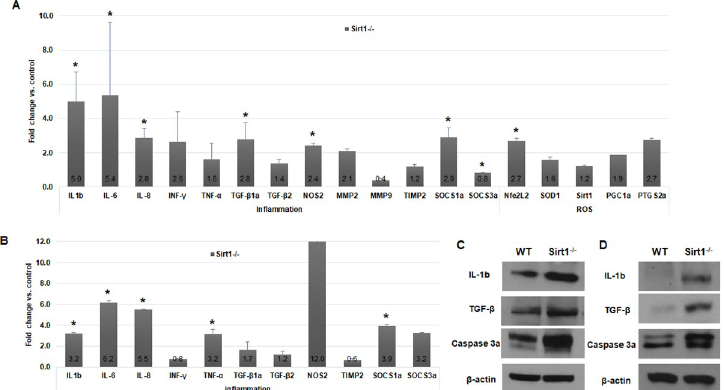
Quantitative RT-PCR showed higher upregulation of inflammation-related genes in Sirt1 -/- than in controls. (C, D) Western blot hybridization showed upregulation of IL-1b, active-caspase 3 and TGF- β . Control, wildtype;